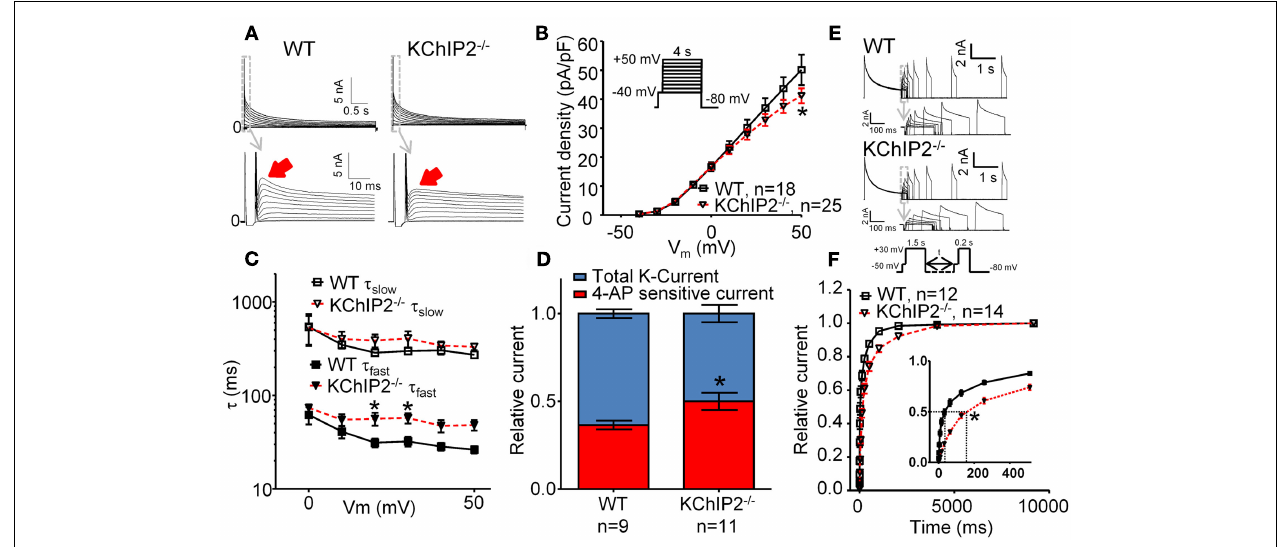
FIGURE 1 |Whole-cell voltage-clamp recordings of outward K-currents recorded in disaggregated left ventricular cardiomyocytes from wild-type (WT) versus KChIP2 − / − mice. Cardiomyocyte isolation and patch-clamp solutions (37˚C) were made according to (Brouillette et al., 2004) with minor modifications. Cadmium (300 μ M) was added to inhibit L-type Ca 2 + currents. (A) Representative current traces showing that KChIP2 − / − cardiomyocytes lack a fast decaying component of the outward K-current (solid arrows). (B) Peak current density as a function of test potential, however, was not significantly changed at any voltage (inset, voltage protocol). (C) The decay of the outward current (0–700ms) was fitted to a second-order exponential function to obtain time-constants ( τ ) of inactivation for positive test potentials. No differences betweenWT and KChIP2 − / − were found for the slow component; however, the fast component of the current decay was significantly slower for KChIP2 − / − myocytes, confirming the loss of a transient component. (D) In order to dissect I K,slow1 from I to,f , the current